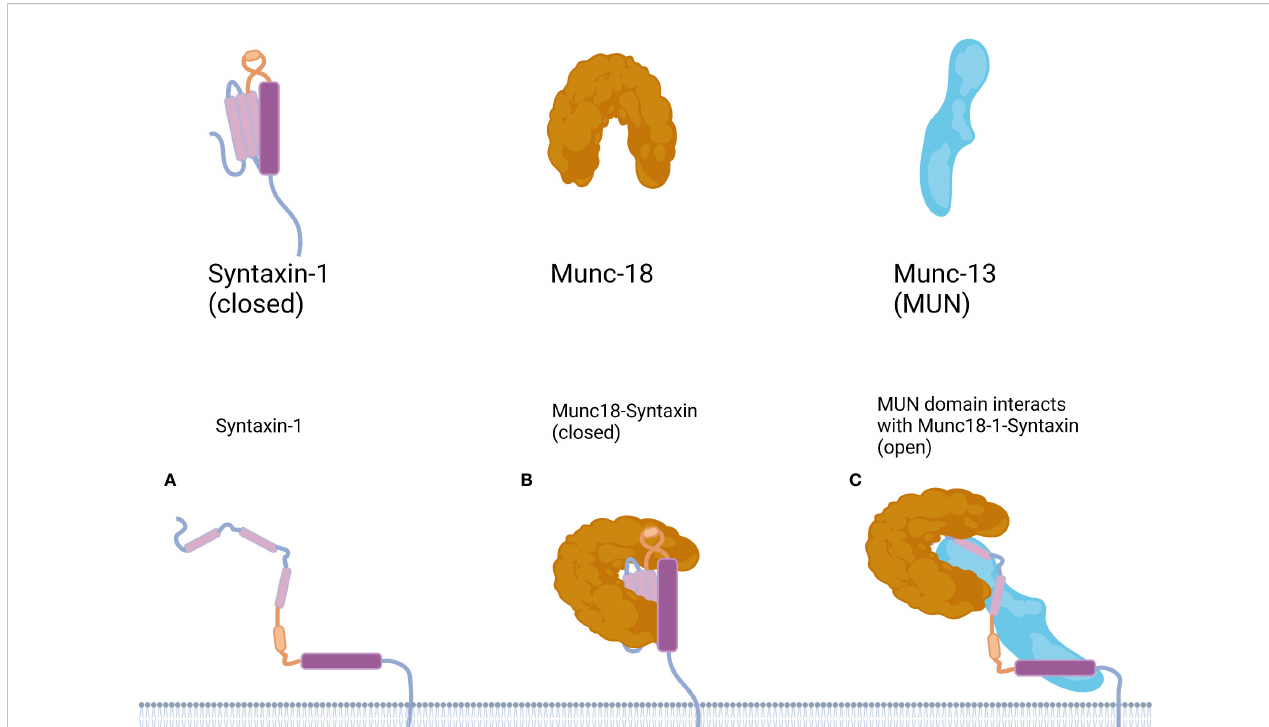
FIGURE 2 Working model for the mechanism underlying the conformational transition of Syntaxin-1. (A) In the Syntaxin-1 molecule the Habc domain is shown in pink, the linker region in yellow and the SNARE motif in purple. (B) Munc18-1 protects Syntaxin-1 into a closed conformation, in the open conformation, the Habc domain of Syntaxin-1 folds back into the SNARE domain to form a closed conformation. (C) Binding of the MUN domain to Munc18-1 and Syntaxin-1 is proposed to transiently open Syntaxin-1. Munc18-1/syntaxin-1/MUN complex leads to a conformational change in the syntaxin-1 linker region may expose the N-terminal end of the H3 domain of syntaxin-1, thereby providing a nucleation site for SNAP-25 and synaptobrevin-2 binding, and in the open conformation the Habc domain is released from the H3